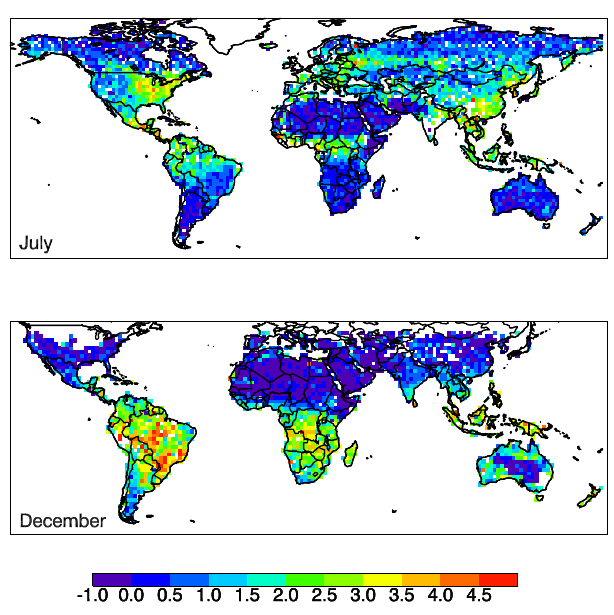
Fig. 10. Derived monthly averages for scaled fluorescence (unitless) from GOSAT for July and December 2009 for the P polarization. 36